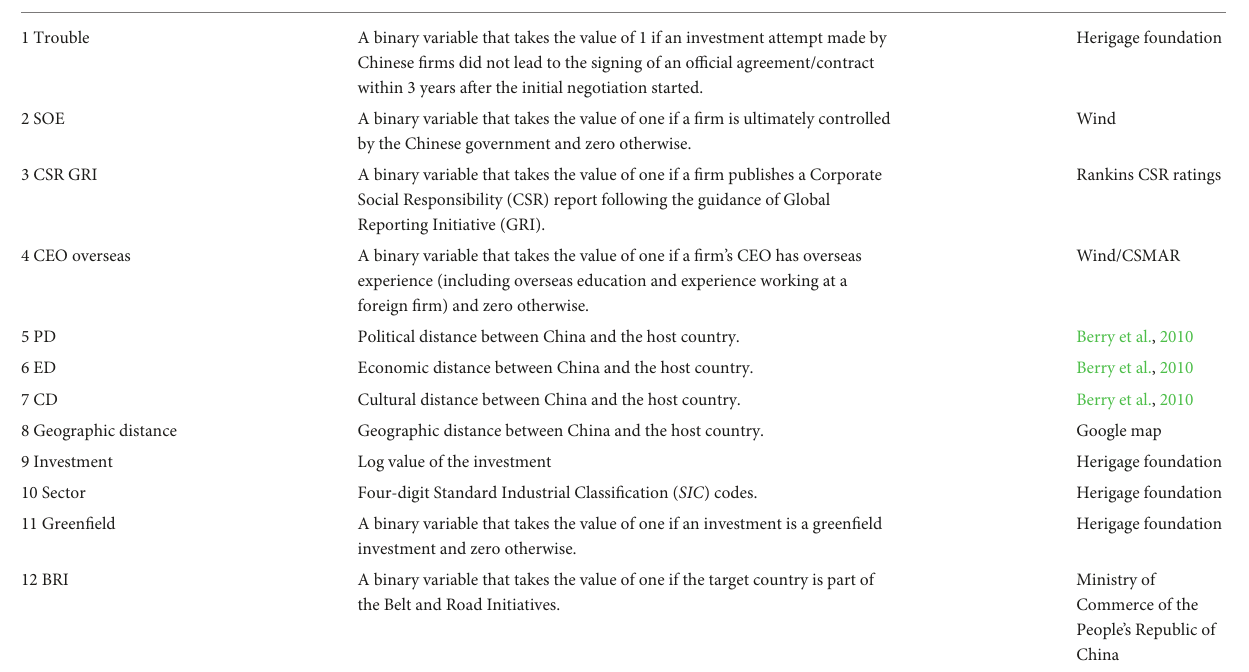
TABLE 2 Variable description, measurement, and sources.